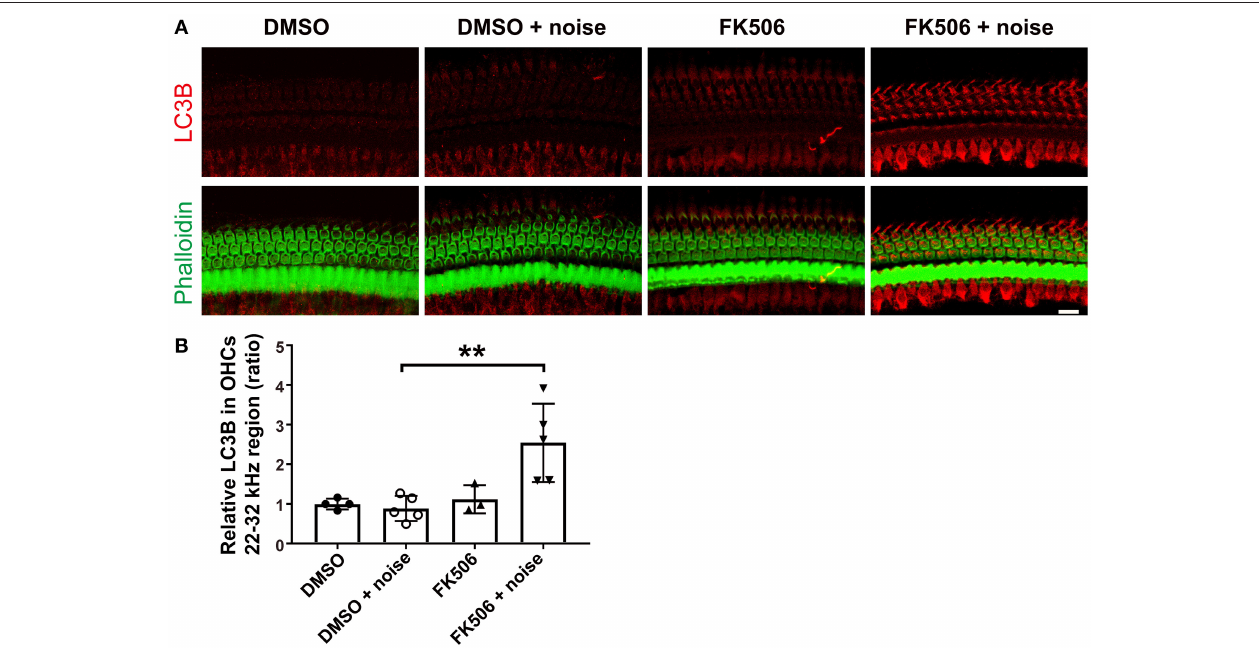
FIGURE 4 | Treatment with FK506 increases LC3B in outer hair cells (OHCs). (A) Surface preparations show that immunolabeling for LC3B (red) in OHCs was increased after treatment with FK506 when assessed 3h after the completion of noise exposure. Green, phalloidin labeling of sensory hair cells. Images were taken from the basal turn corresponding to sensitivity to 22–32kHz, and each figure is representative of three to five individual mice for each condition. Scale bar = 10 µ m. (B) Quantification of relative LC3B immunolabeling intensity in grayscale in OHCs normalized to dimethyl sulfoxide control mice confirms enhancement by treatment with FK506. Data are presented as individual points with means ± SD; each condition was examined in one ear per mouse; ** p <